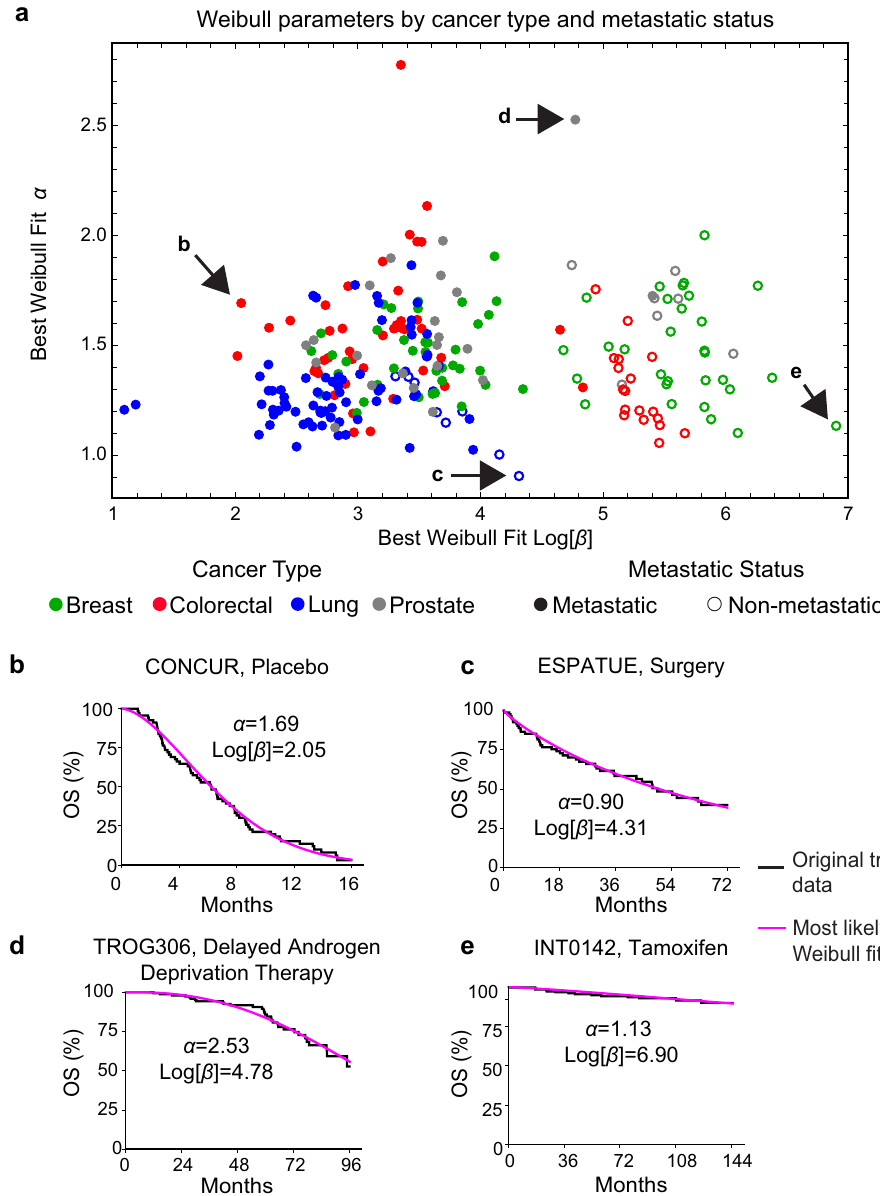
Fig. 5 Best- fi t Weibull parameter values for trials reporting overall survival (OS) data. Weibull fi ts for trials reporting OS data, encompassing 237 survival curves from 116 trial fi gures. a Survival distributions categorized by cancer type and metastatic status (de fi ned as trials that included patients with distant metastases). Representative survival functions and fi ts for trials across a variety of cancer types including b metastatic colorectal cancer (NCT01584830) c non-metastatic lung cancer (NCT number not reported) d metastatic prostate cancer (NCT00110162) and e non-metastatic breast cancer (NCT number not